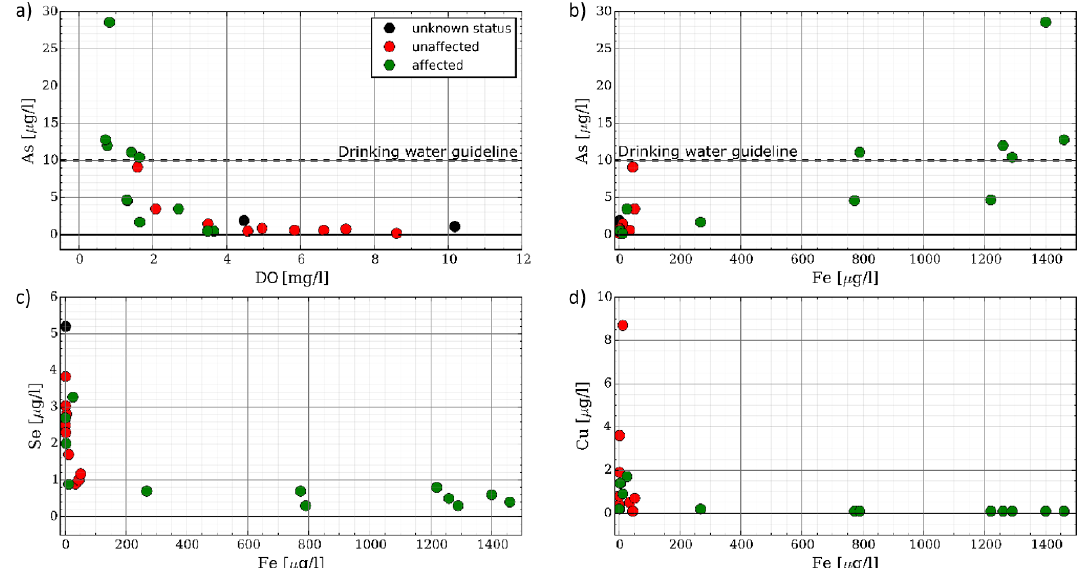
Figure 4. Trace metal and metalloid concentrations are strongly correlated to the redox conditions in groundwaters from the Tertiary Limestone Aquifer. Shown here are arsenic concentrations versus ( a ) dissolved oxygen, ( b ) ferrous iron, ( c ) selenium and ( d ) copper versus ferrous iron concentrations.